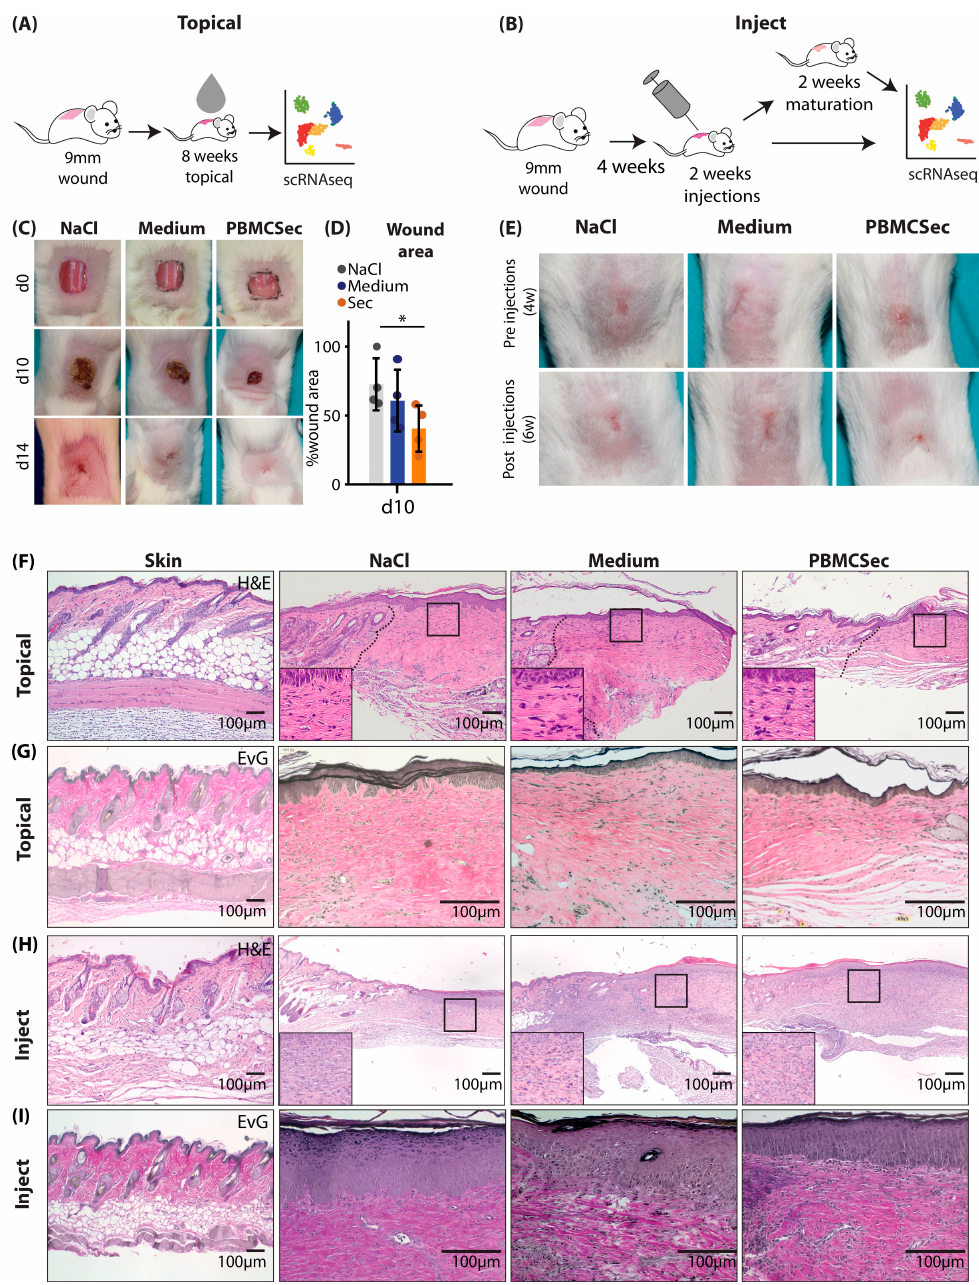
Figure 1. Comparison of PBMCsec-mediated effects on scars after topical or intradermal application. ( A , B ) Illustration of “topical” or “inject” workflow for mouse scars: ( A ) square wounds of 9 × 9 mm were excised on mouse backs (n = 4 per group), treated with topical PBMCsec for 8 weeks, and subjected to scRNAseq; (B) square wounds of 9 × 9 mm were excised on mouse backs (n = 4 per group), left to mature for 4 weeks, injected with PBMCsec for 2 weeks, and subjected to scRNAseq, or matured for another 2 weeks and then subjected to scRNAseq. ( C ) Wound documentation of topically treated scars on post-wounding days 0, 10, and 14. * indicates p < 0.05 in one-way ANOVA ( D ) Wound area measurements normalized to the d0 wound area of each respective wound. ( E ) Scar documentation of mouse scars before and after injections. ( F ) Hematoxylin/eosin staining of ”topical” mouse wounds. ( G ) Elastica van Gieson (EvG) staining of ”topical” mouse wounds. ( H ) Hematoxylin/eosin staining of ”inject” mouse wounds. ( I ) Elastica van Gieson (EvG) staining of ”inject” mouse wounds.